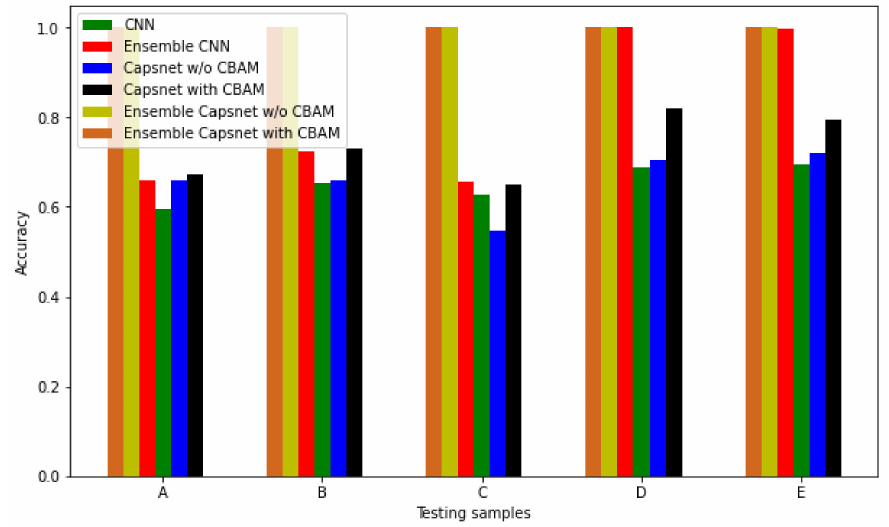
Figure 11. The diagnostic accuracy of six different diagnostic models.